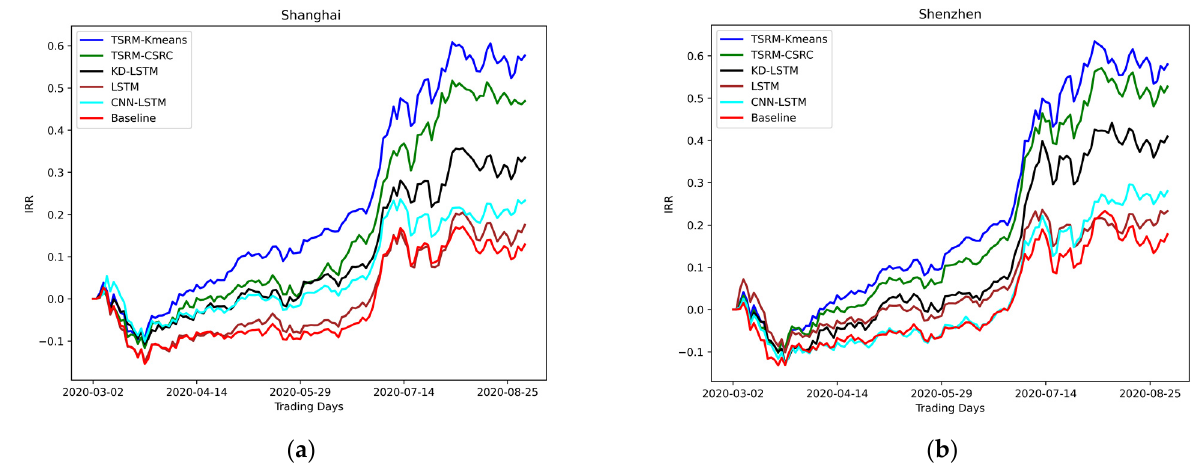
Figure 5. ( a ) Investment–return ratio (IRR) of different models in Shanghai markets; ( b ) Investment–return ratio (IRR) of different models in Shenzhen markets. Table 3. Comparison of models’ backtesting experimental.